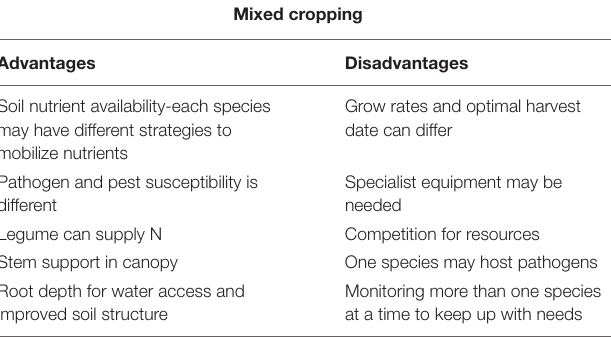
TABLE 1 | The advantages and disadvantages of growing forage crops in mixed